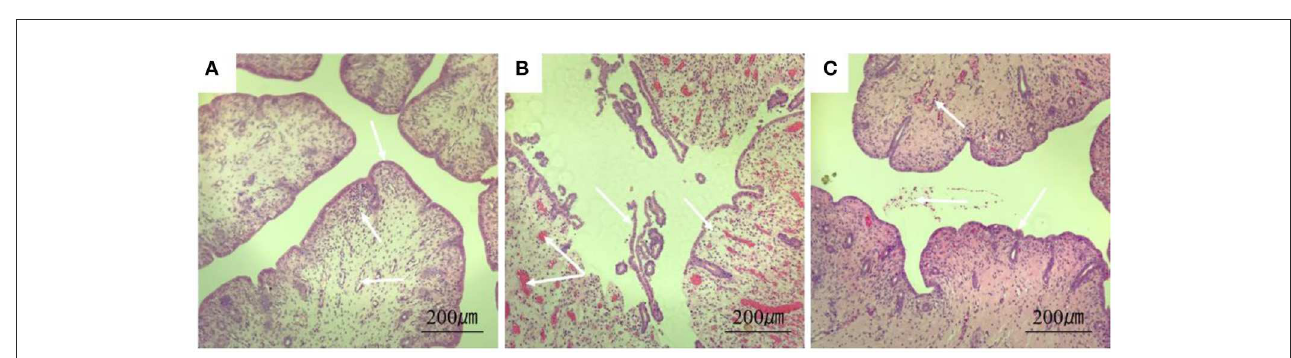
FIGURE5 Section of rabbit uterine tissue (100 × , H&E staining). (A) Rabbits in the control group; (B) rabbits in the model group; (C) rabbits in the treatment group. Arrows point to: endometrial cells, uterine vascular lumen, and lymphocytes.